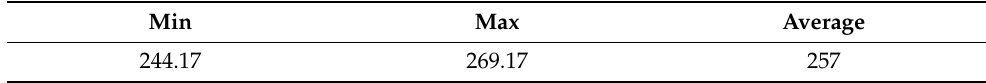
Table 8. CFRP tendon ( φ = 12 mm)—assumed breaking loads ( P u